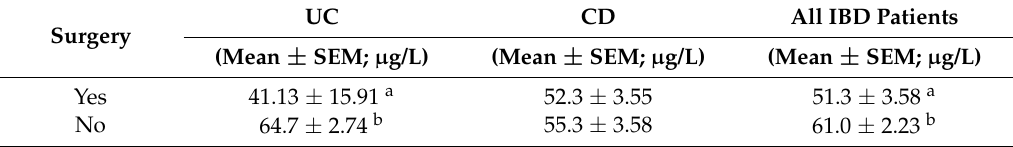
Figure 1. Mean serum Se levels in patients with ulcerative colitis (UC) or Crohn’s disease (CD) and healthy controls ( p < 0.01; mean values with different letters (a,b,c), significant difference). Table 1. Serum Se concentrations of IBD patients as a function of surgery Table 1. Serum Se concentrations of IBD patients as a function of surgery (yes/no).